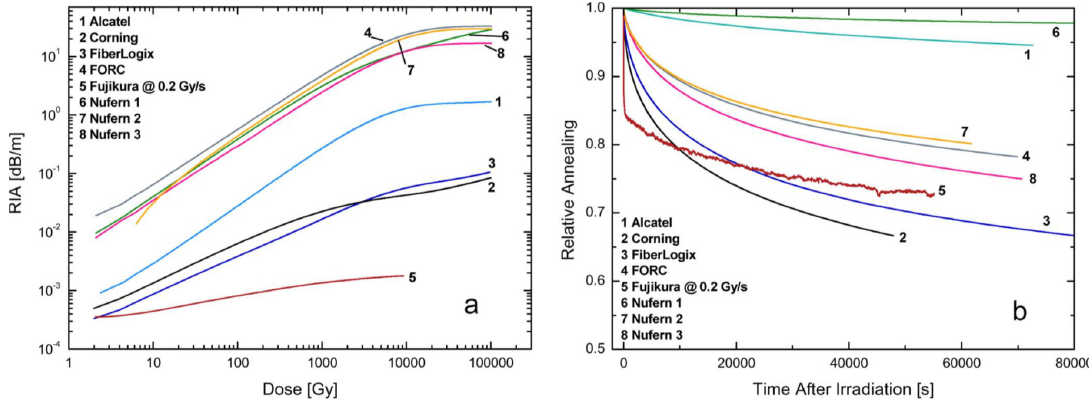
Figure 1. ( a ) Radiation induced attenuation in different fibers at a dose rate of 1 Gy/s and ( b ) relative recovery after the irradiation. © 2010 IEEE. Reprinted with permission from [65].